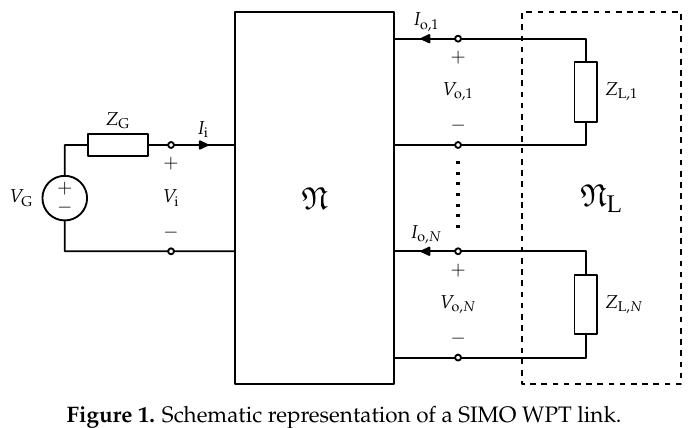
Figure 1. Schematic representation of a SIMO WPT link.